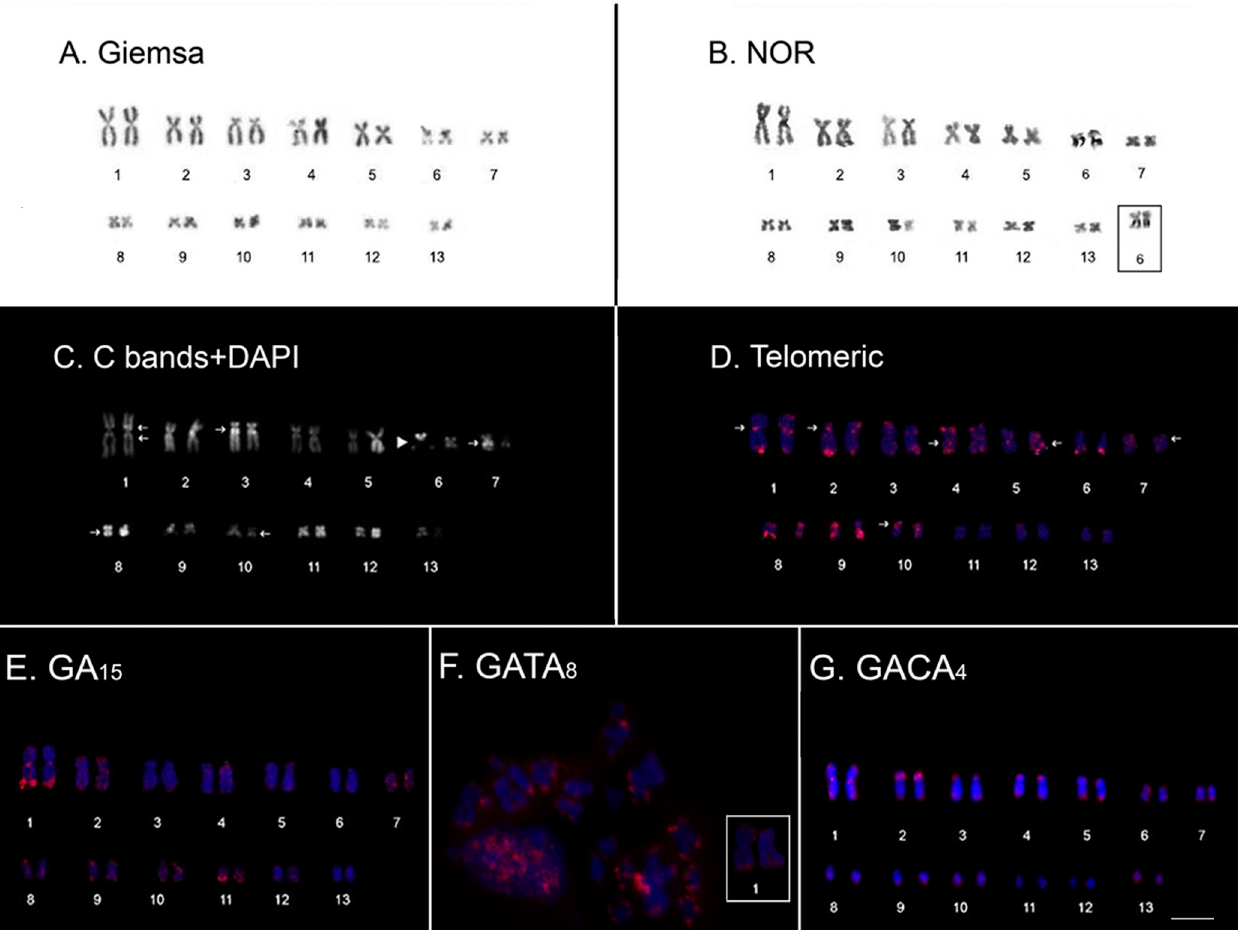
Fig 1. Karyotype features and microsatellite motifs of Cycloramphus bolitoglossus . Classical cytogenetic features are shown by Giemsa staining ( A ), location of the NORs, revealed by silver impregnation ( B ), and the heterochromatin revealed by C-banding + DAPI staining ( C ). Molecular cytogenetic mapping of the telomeric probe ( D ) and microsatellite motifs (GA) 15 ( E ), (GATA) 8 ( F ). and (GACA) 4 ( G ). Bar: 5 μ m.